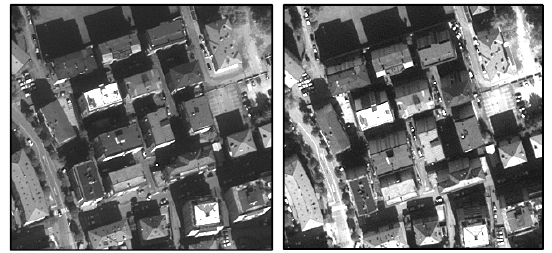
Figure 7. Example of occlusion between tall buildings in